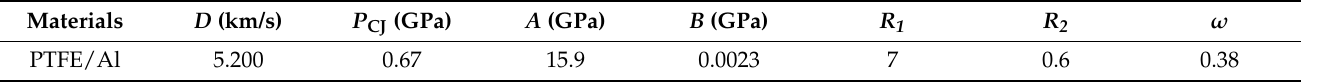
Table 7. Main parameters of the reacted PTFE/Al reactive materials.